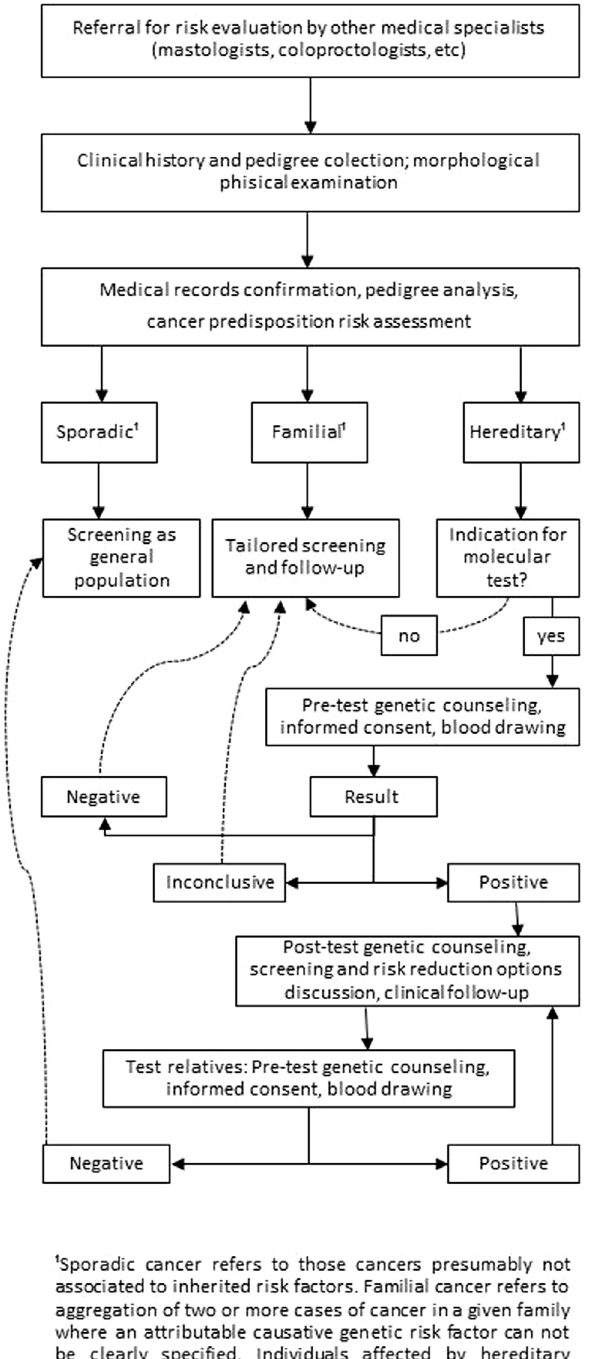
Figure 1 - Stages of the Genetic Counseling process at Barretos Cancer Hospital (adapted from Palmero et al. ,